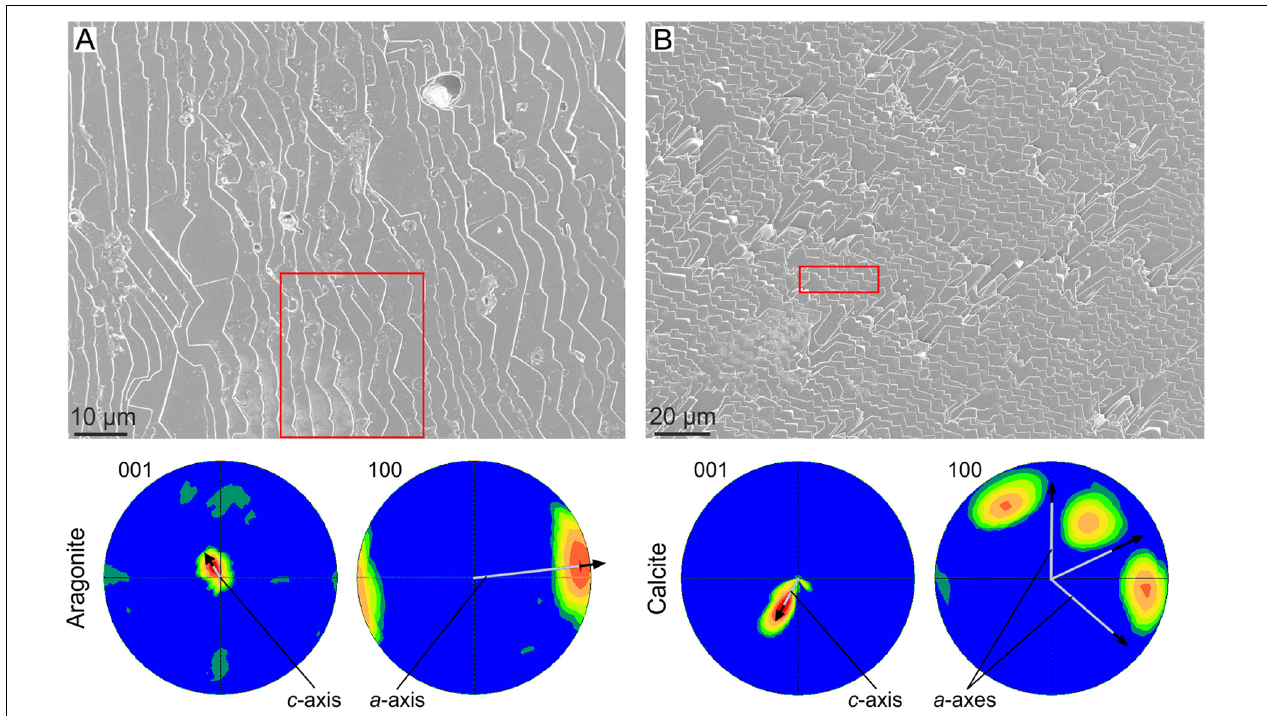
FIGURE 4 | Crystal coorientation in foliated materials. (A) Foliated aragonite of the monoplacophoran Rokopella euglypta . (B) Foliated calcite of the bivalve Anomia ephippium . In both cases, the EBSD pole figures of the areas framed in red [the position of the area in (B) is approximate] are shown below. For both materials, the small scatter of the pole figure maxima indicate a good co-orientation of both the c - (001 pole figures) and a -axes (100 pole figures). The average orientations of the crystallographic axes is indicated. Their inclinations with respect to the plane of the image are inversely proportional to their lengths, e.g., for aragonite, the c -axis is at a high angle to the image plane, whereas the a -axis is at a low angle (close to the